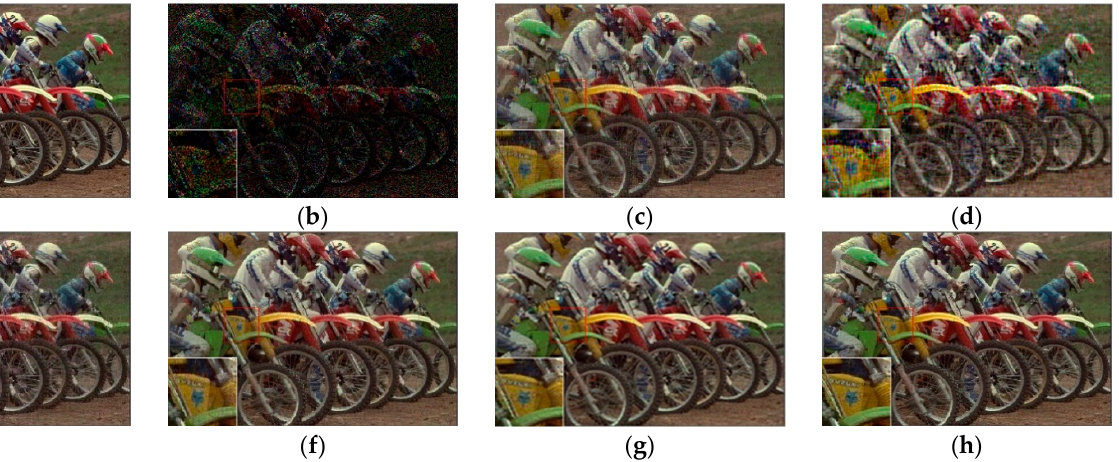
Figure 8. Visual effect comparison of different methods on the color image kodim05. The incomplete image contains 70% missing entries, shown as black pixels. ( a ) Original image; ( b ) Incomplete image; ( c ) FaLRTC (21.80 dB); ( d ) TCTF (19.41 dB); ( e ) LRTC-TNN1 (22.67 dB); ( f ) LRTC-TNN2 (24.59 dB); ( g ) LRTV-TTr1 (24.48 dB); ( h ) SLRTC (26.14 dB).